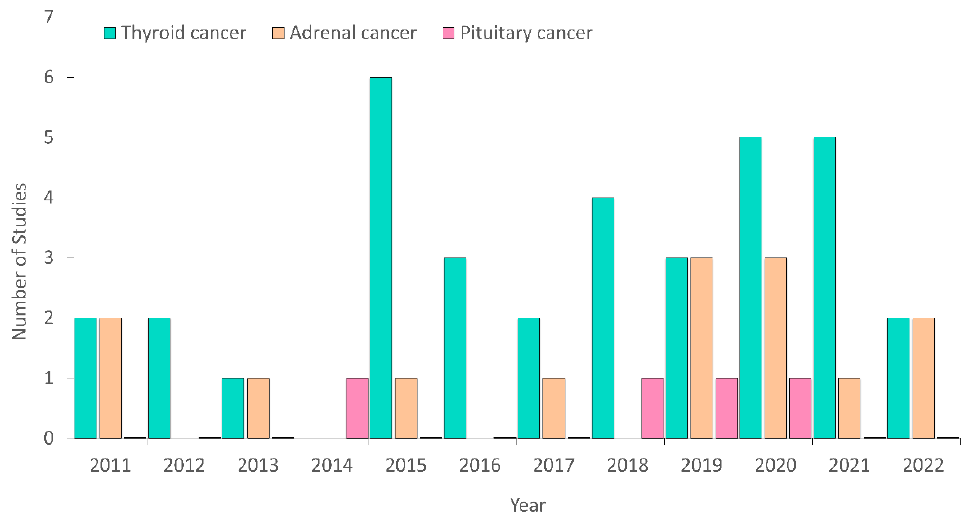
the past 12 Figure 2. The number of metabolomics studies performed to study various endocrine cancers over the past 12 years.